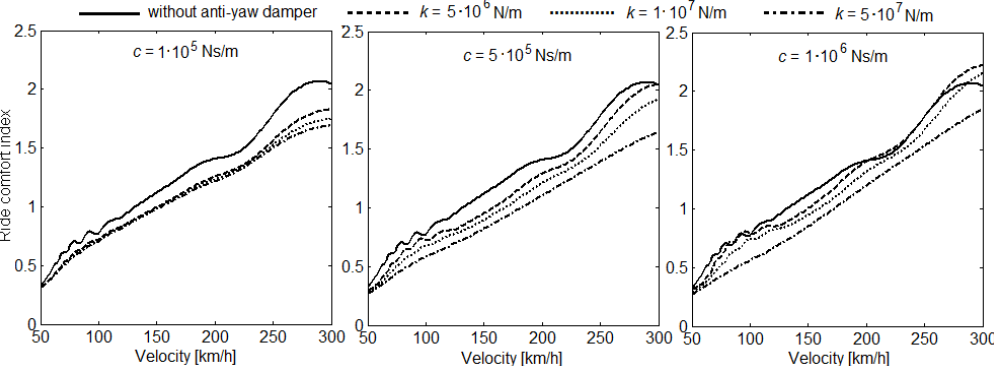
Figure 11. Influence of damping and stiffness of the anti-yaw damper upon the ride comfort index in the front bogie.